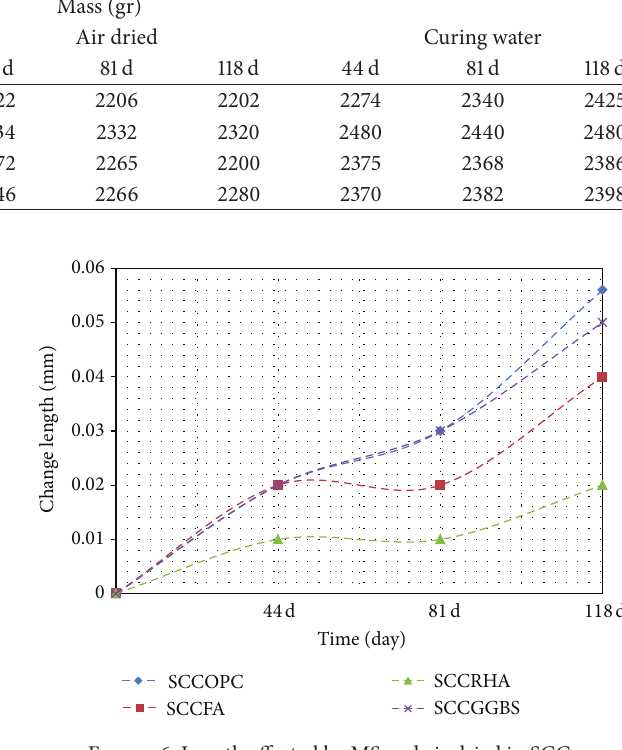
Figure 6: Length affected by MS and air dried in